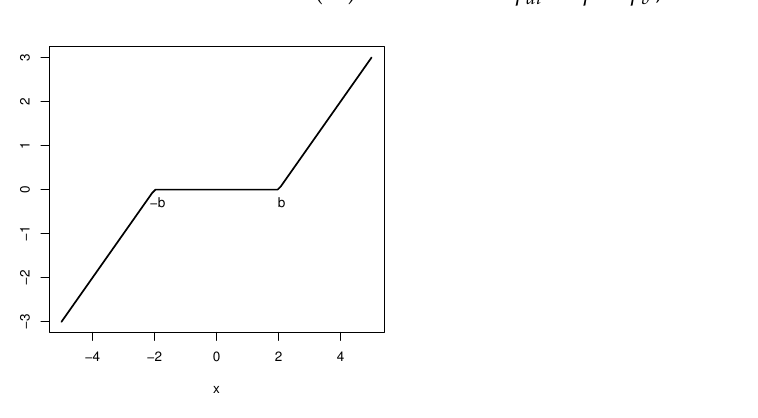
Figure 8. Score function defining the Difference M -estimator with tuning constant b